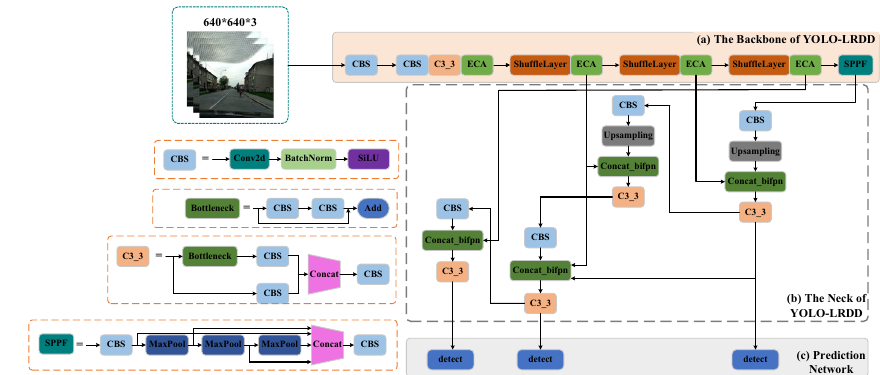
Fig. 3 Network architecture of the YOLO-LRDD